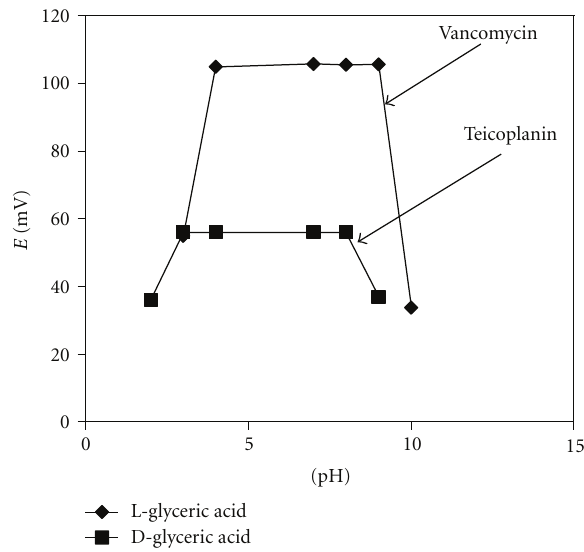
Figure 1: E ff ect of pH on the response of the EPMEs to L- glyceric acid (10 − 8 moL/L L-GA) and D-glyceric acid (10 − 3 moL/L) solutions. (I) Vancomycin-based EPME; (II) teicoplanin-based EPME. Table 2: Potentiometric selectivity coe ffi cients for the electrodes proposed for the assay of L- and D-glyceric acids a . Interference species (J)